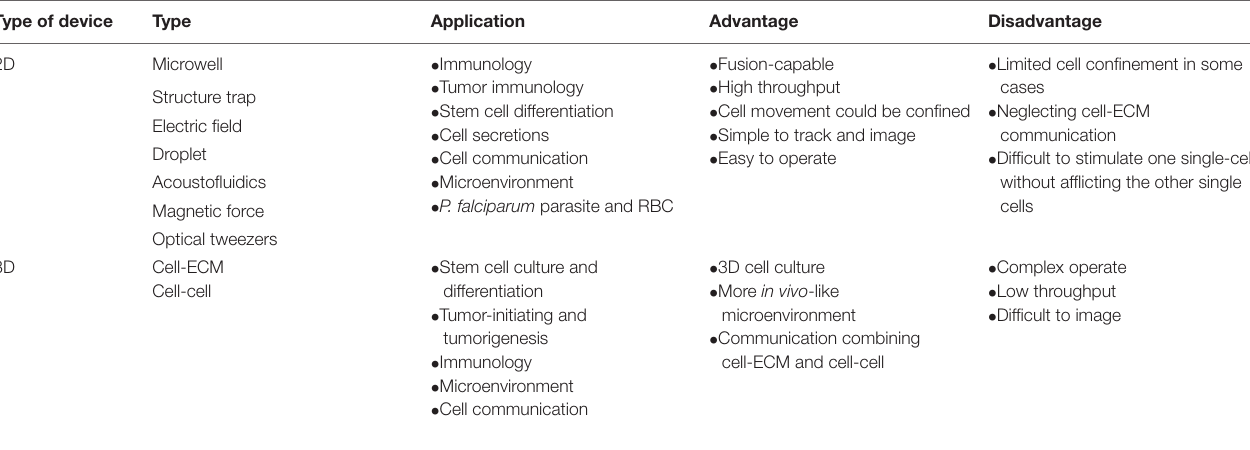
TABLE 3 | Overview of microfluidics techniques for cell-cell communication study at a single-cell level. Type of